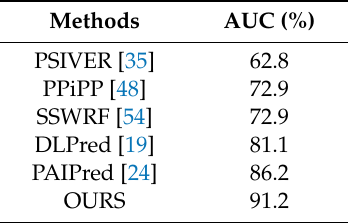
Table 3. Comparison with existing PPIs site predictors.